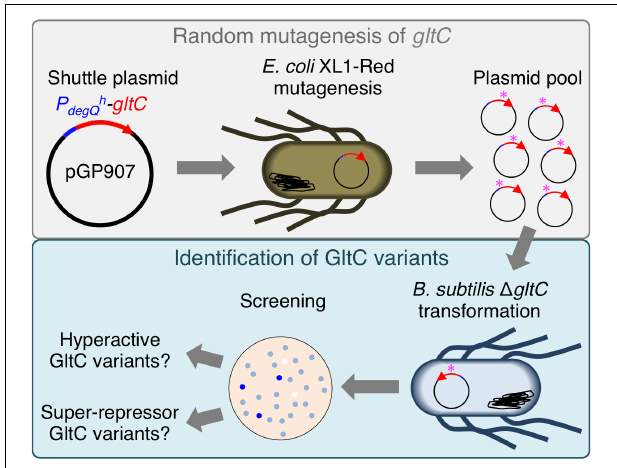
FIGURE 2 | Working flow describing the random mutagenesis procedure for isolating GltC variants with enhanced activator and repressor